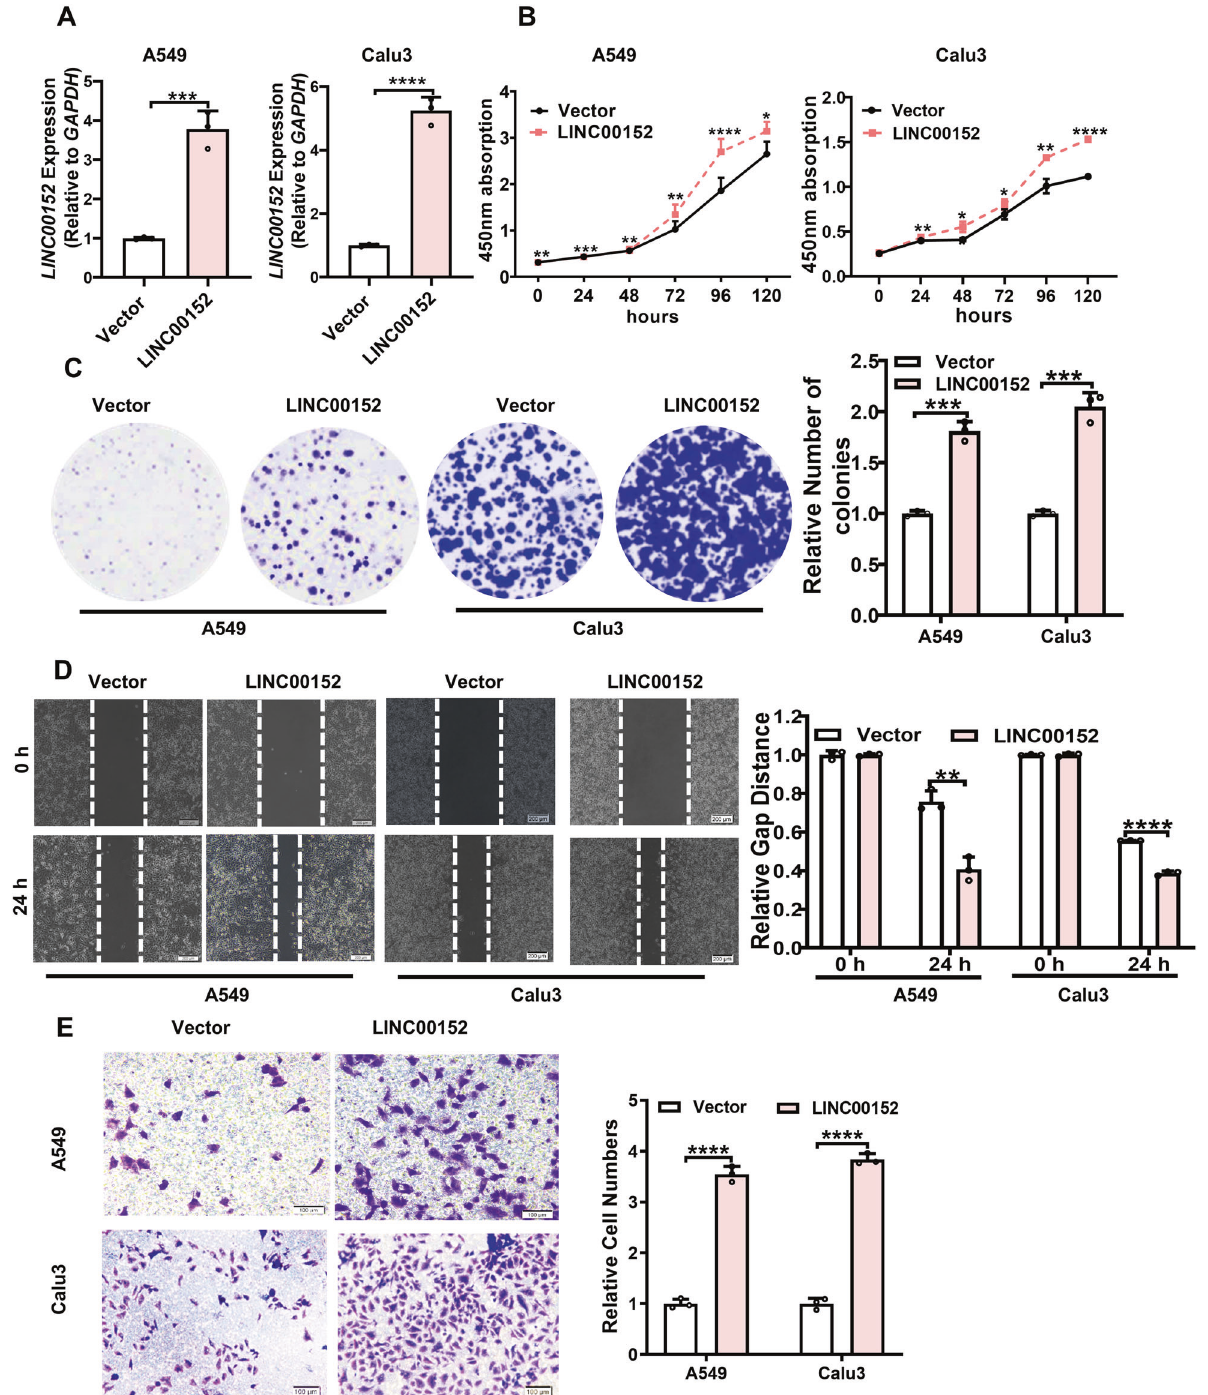
Fig. 5 Overexpression of LINC00152 promotes the survival, invasion and migration of LUAD cells in vitro. A LINC00152 expression was detected after transfection of pcDNA3.1-LINC00152 plasmid into A549 and Calu3 cells. B Cell Counting Kit-8 (CCK-8) assays were performed in A549 and Calu3 cells with overexpressing LINC00152. C Overexpression of LINC00152 promotes the colony formation of cells. D The migratory potential of LINC00152 overexpression together with their controls was analyzed in a wound-healing assay. Scale bar: 200 μ M. E The invasive potential of LINC00152 overexpression together with their controls was analyzed by a transwell assay. Scale bar: 100 μ m. Data shown are representative images or expressed as the mean ± SD of each group from three separate experiment (** p <0.01; *** p <0.001; **** p <0.0001. Student ’ s t -test).